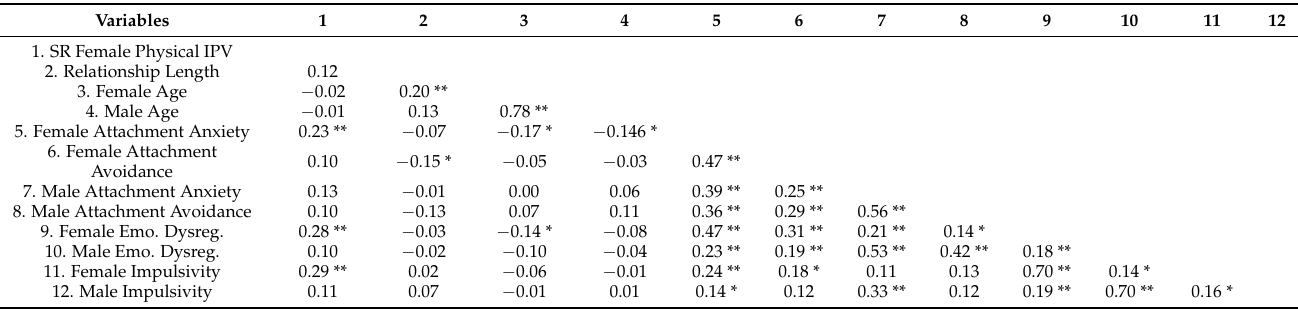
Table 4. Bivariate correlations among self-reported female physical IPV, relationship length, age, attachment, emotion dysregulation, and impulsivity.